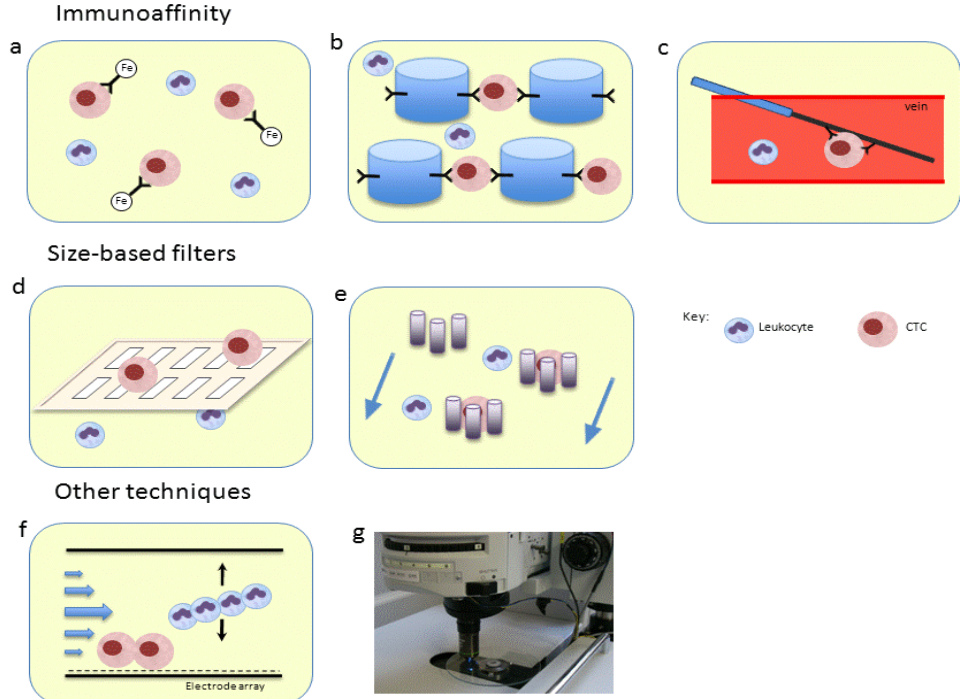
Figure 1. CTC isolation techniques. Immunoaffinity utilizes EpCAM antibodies bound to ( a ) magnetic beads (CellSearch ® ); ( b ) microposts (CTC-chip); or ( c ) an in-vivo wire. Size-based techniques use ( d ) pore, slot filters or ( e ) microcrescents. Other techniques include ( f ) dielectrophoresis and ( g ) high speed laser